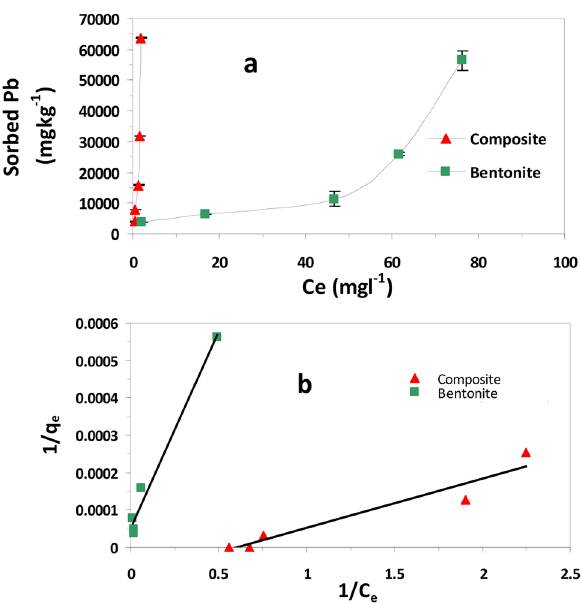
Figure 5. Lead adsorption isotherms for bentonite and nanocomposite (nMgO-bentonite) ( a ) and Langmuir isotherms model for the two sorbents ( b